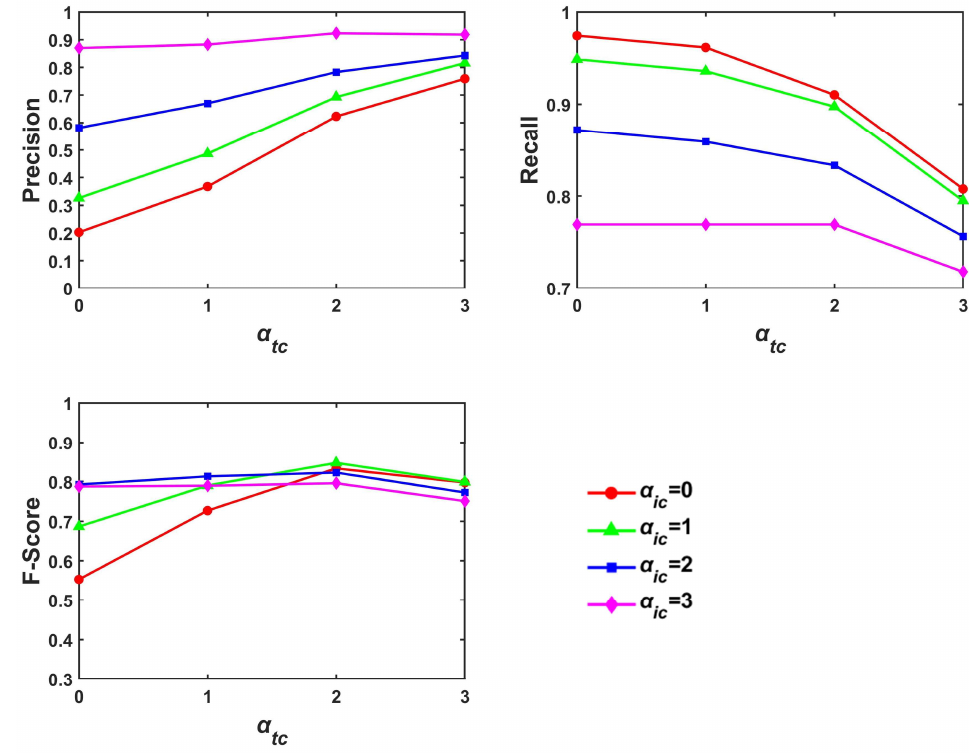
Figure 6. Leakage detection performance for the water-consumption time series data set under different threshold coefficients.